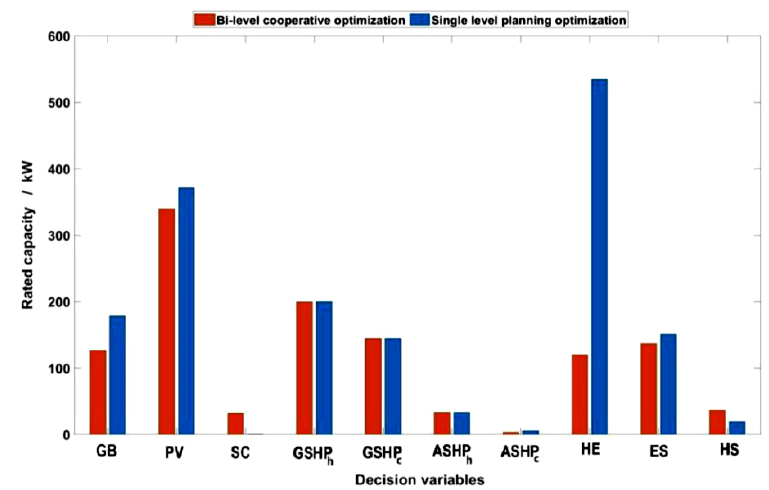
Figure 9. Comparison of decision variables under optimal decisions.